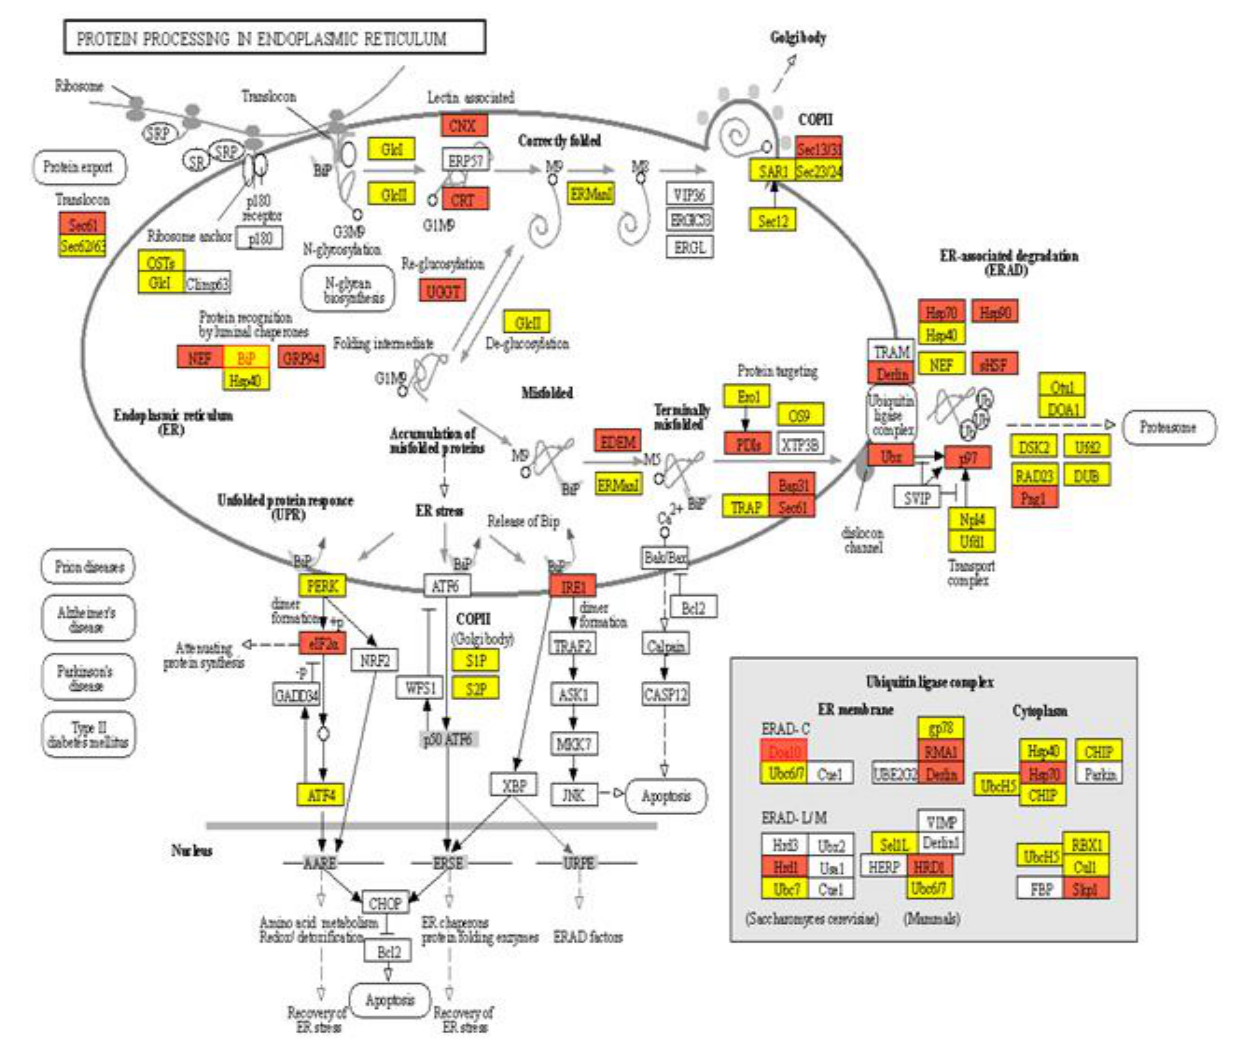
Figure 9. KEGG pathway analysis identified the ER-associated protein trafficking pathway (ko04141) for DEGs between 10 DPA, 14 DPA, 20 DPA, and 30 DPA. Red, yellow, and white indicate genes expression increase, decrease, and mixed change at all selected 10, 14, 20, and 30 DPA, respec- tively. Table 3. Summary of DEGs related to ER protein quality control pathways based on the KEGG database of developing grain at all selected stages.